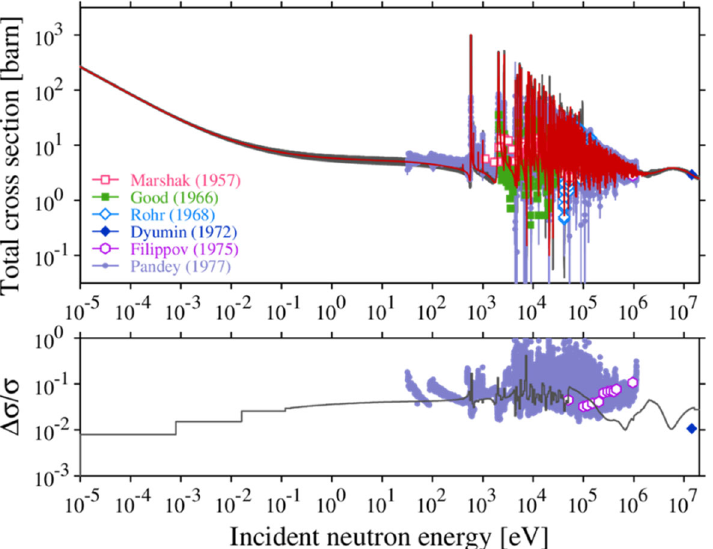
Fig. 2. 63 Cu neutron total cross sections estimated by T6 system (gray lines) compared with ENDF/B-VIII.0 (red line) and experimental data and the errors [12-17].